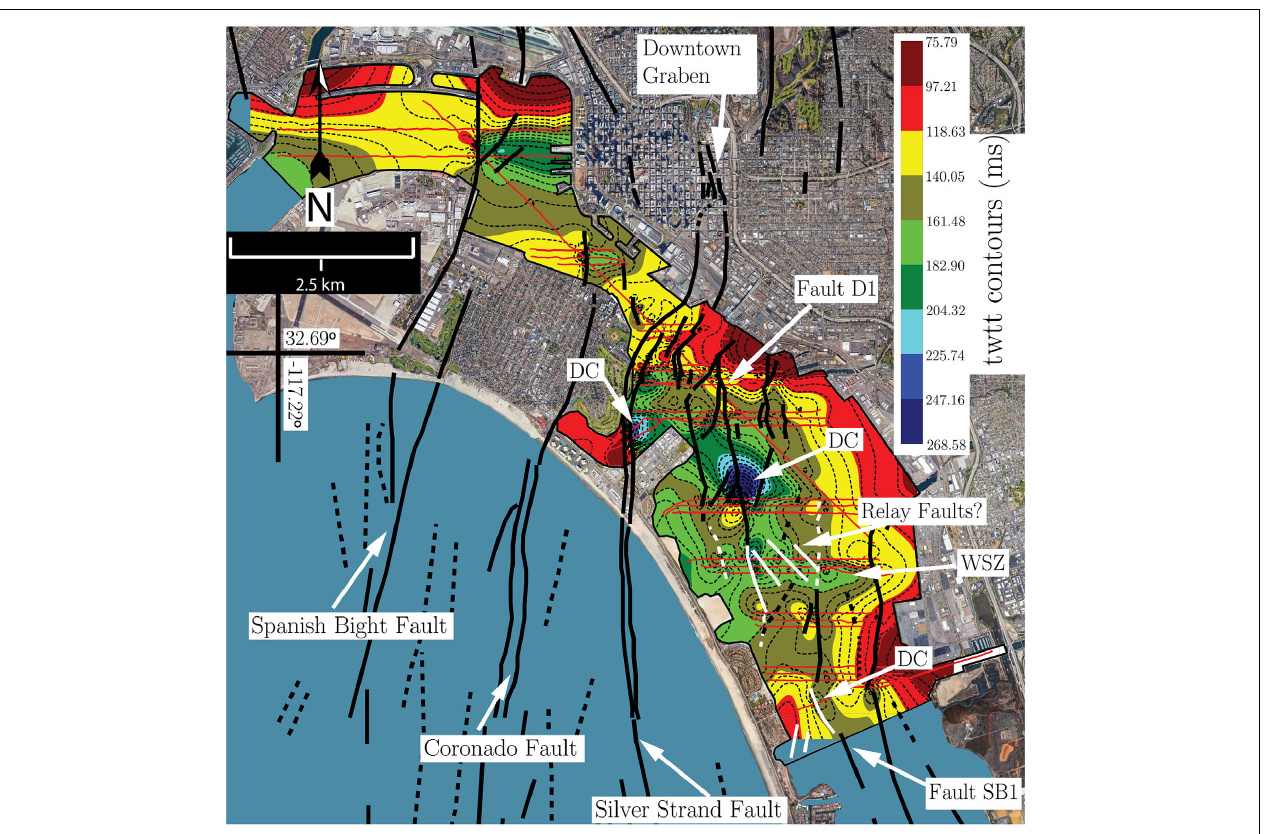
FIGURE 5 | Horizon 5 gridded surface representing depth to horizon 5 in two-way travel time (twtt). Faults from the USGS Quaternary fault database are shown as black lines (USGS, 2019). White lines are the extended fault traces from this study. Localized depositional centers are seen adjacent to D1, SB1, and the Silver Strand faults. A more westerly oriented area of subsidence (WSZ) is observed between Faults SB1 and D1, possibly corresponding to a potential relay fault structure. Outside the study area, in the northeastern part of San Diego Bay local depositional centers are also observed adjacent Spanish Bight and Coronado faults. DC, Depositional Center; WSZ, Western Subsidence Zone. Figure 5 is approximately collocated with Figure 2 . Background satellite image from Google Earth